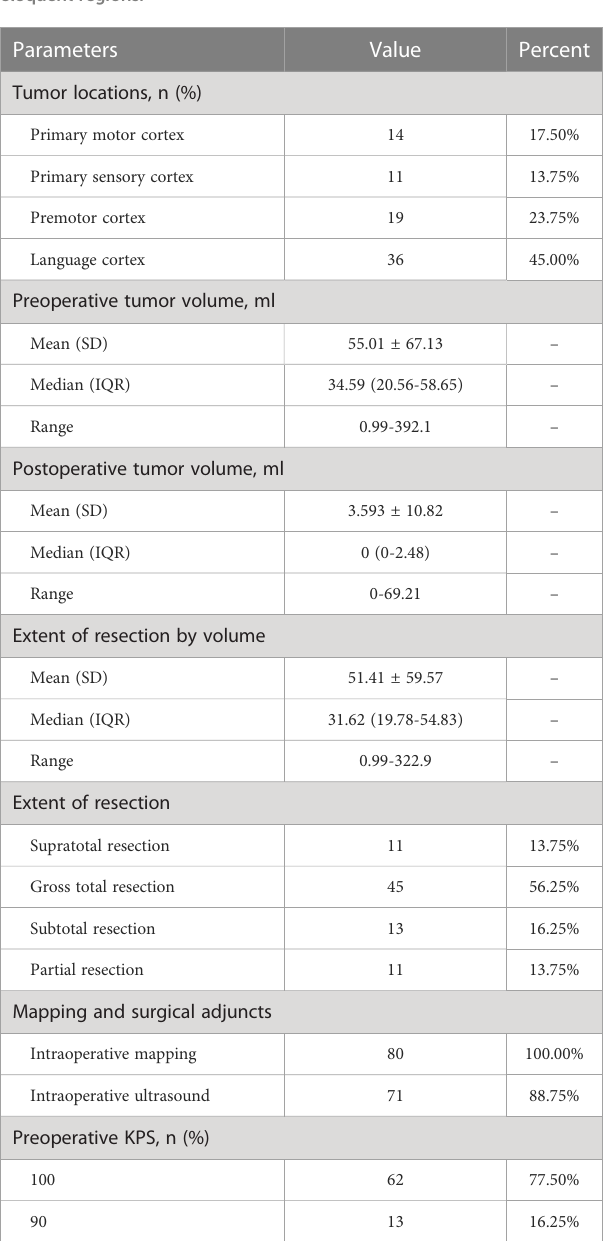
TABLE 2 Surgical characteristics of patients receiving awake surgery in eloquent